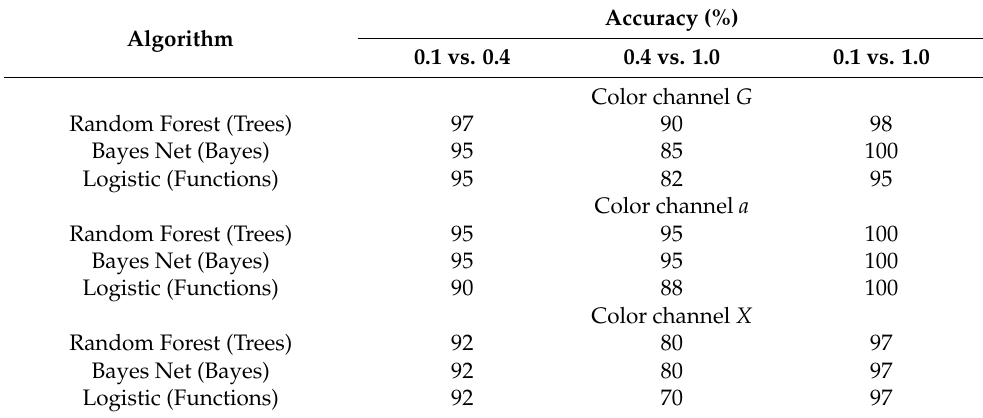
Table 7. The accuracy of distinguishing the ripening stages of ‘Royal Glory’ peaches based on sets of textures selected from flesh images in different color